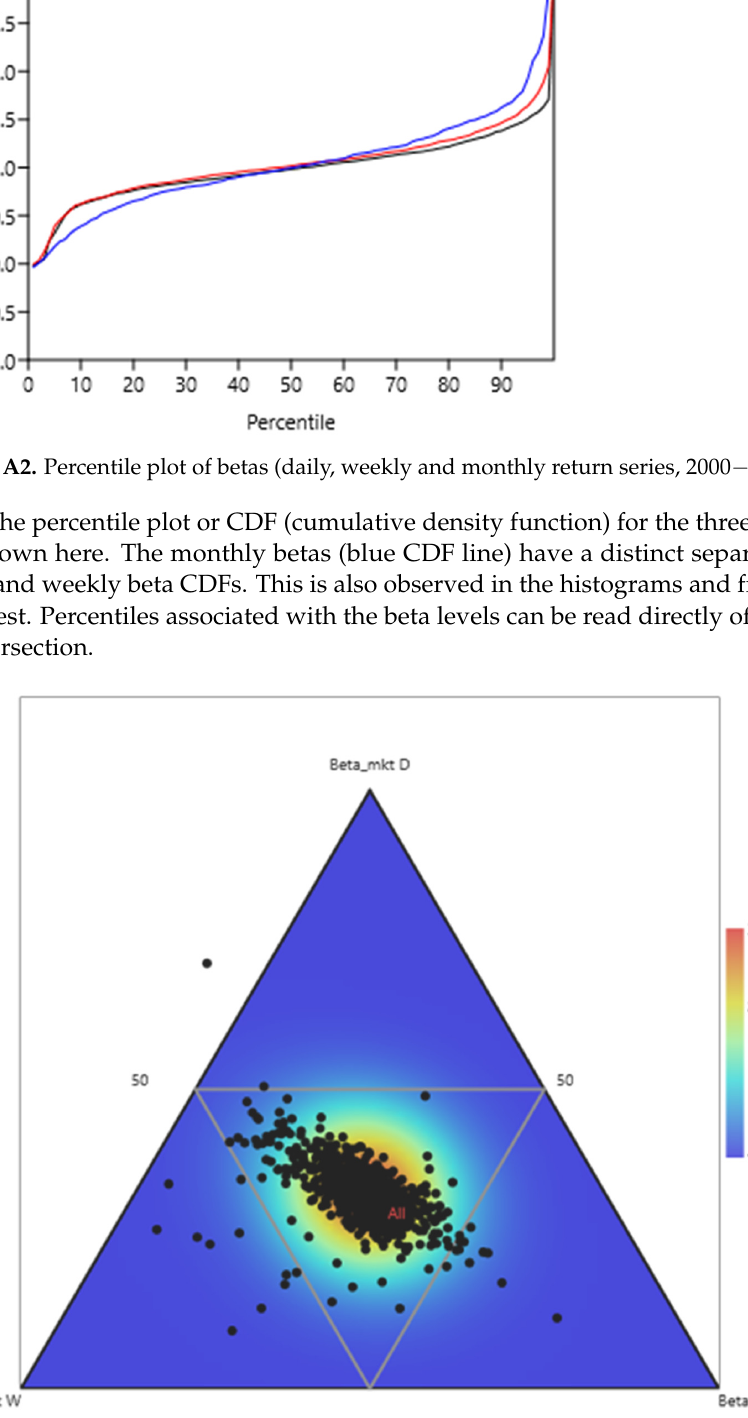
Figure A3. Ternary density plot of betas (daily, weekly and monthly return series,